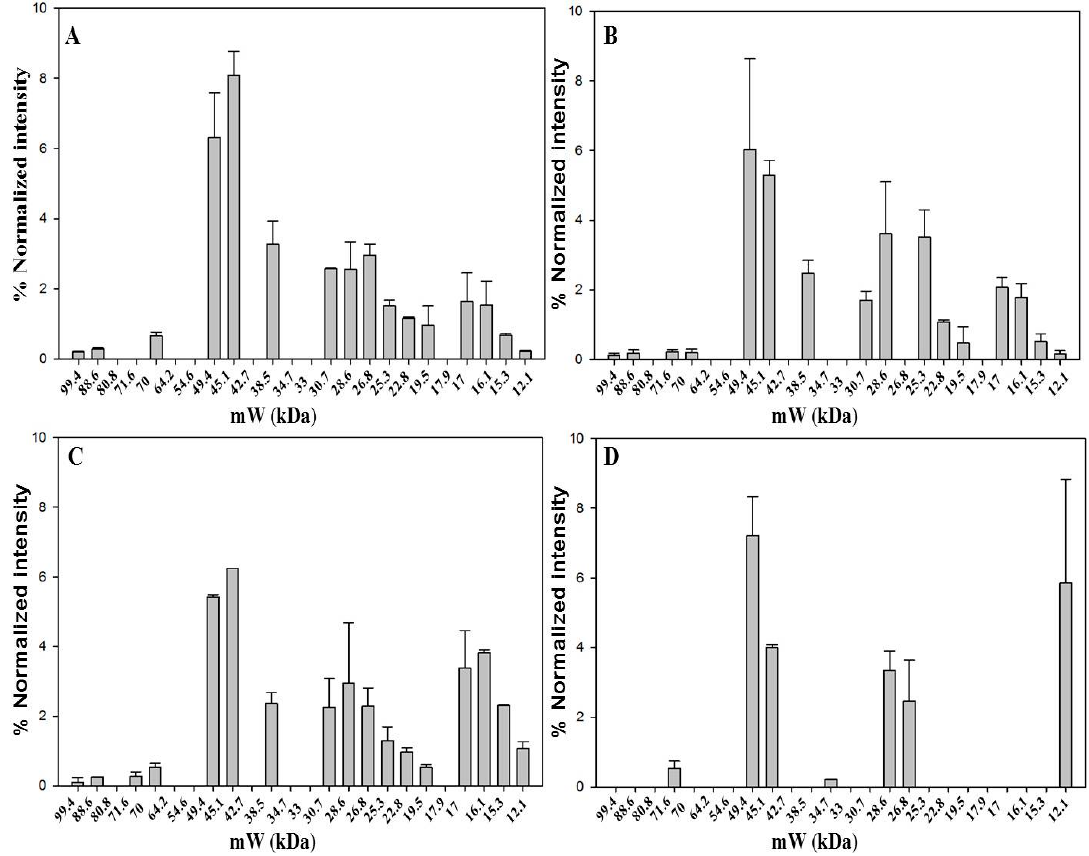
Figure 4. Bands detected in 1D-SDS-PAGE of dried saffron from Ramiseto ( A ); Itria ( B ); market ( C ) and Navelli ( D ). Gel image was acquired with ChemiDoc™ MP System imager and analyzed with Image Lab™ software (version 5.2). Data are from two replicates.